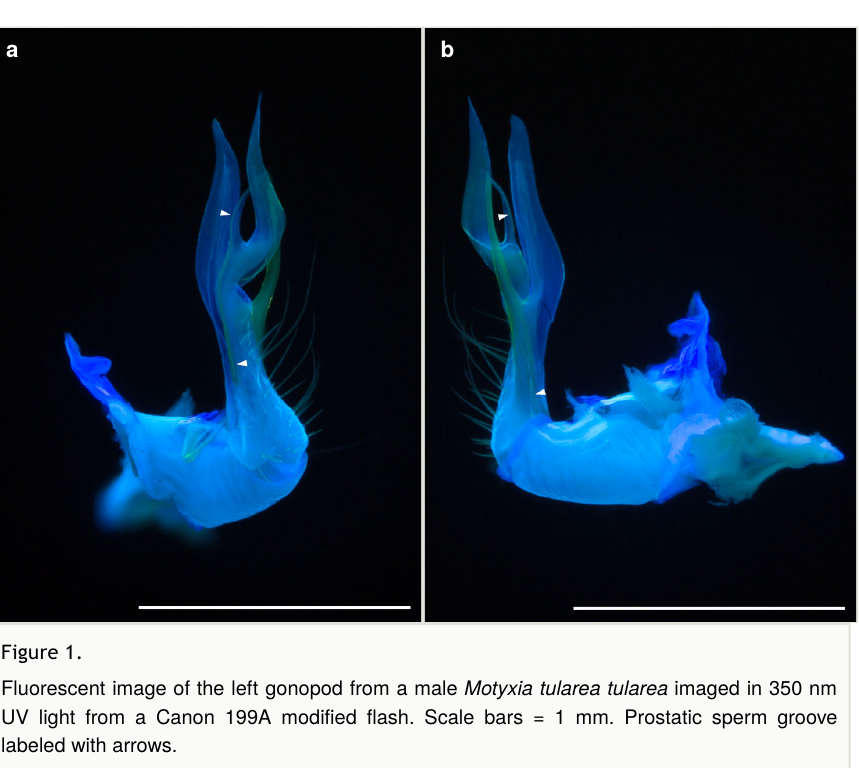
Motyxia sequoiae , Xystodesmidae (Fig. 2a). (Image of the head.) Variable fl uorescence in blue and yellow-green. Labral teeth yellow-green and distinct from the head capsule (Fig. 2a, inset). Incisura lateralis dark blue, tentorium arm visible in the center. Setae dark yellow-green, visible against the light blue background. Apical cones of the antenna yellow- green, and contrasted with the blue background.